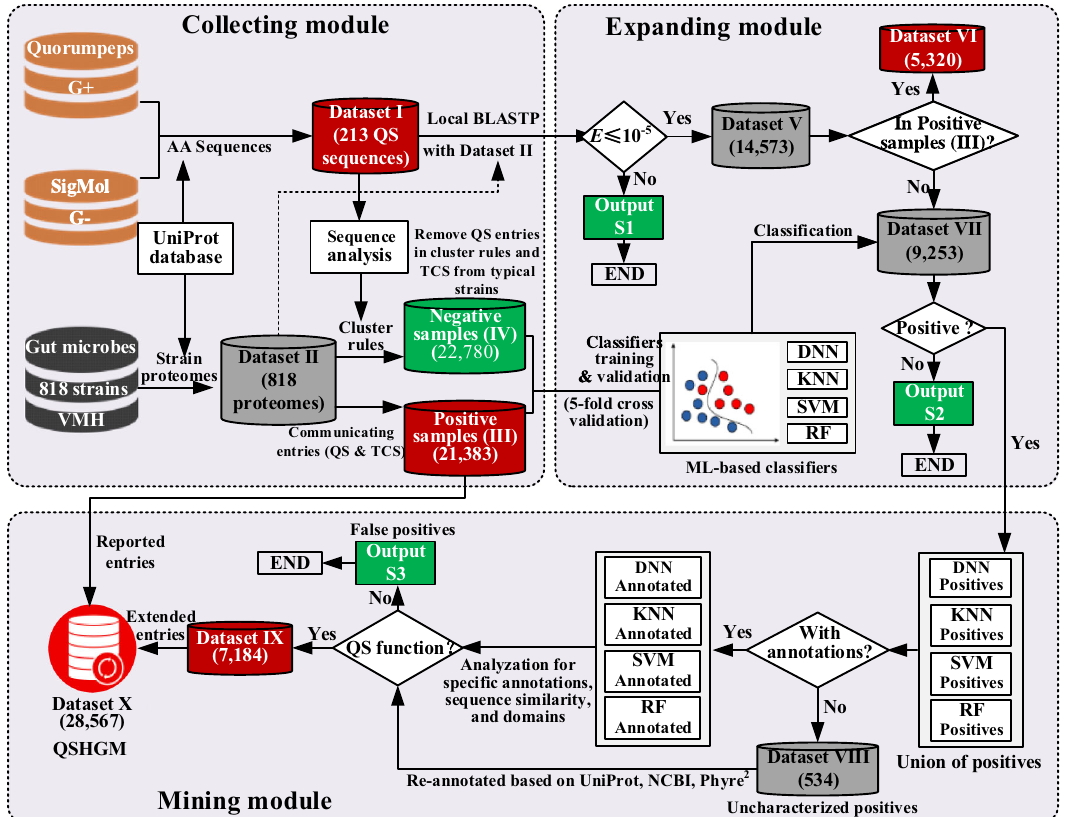
Fig. 1 Schematic diagram of the systematic work fl ow including three modules. There are ten engaged datasets in our systematic work fl ow, i.e., 213 validated QS entries from Gram-positive (G + ) and Gram-negative (G − ) microbes (Dataset I) (Supplementary Data 1), 818 proteomes for the